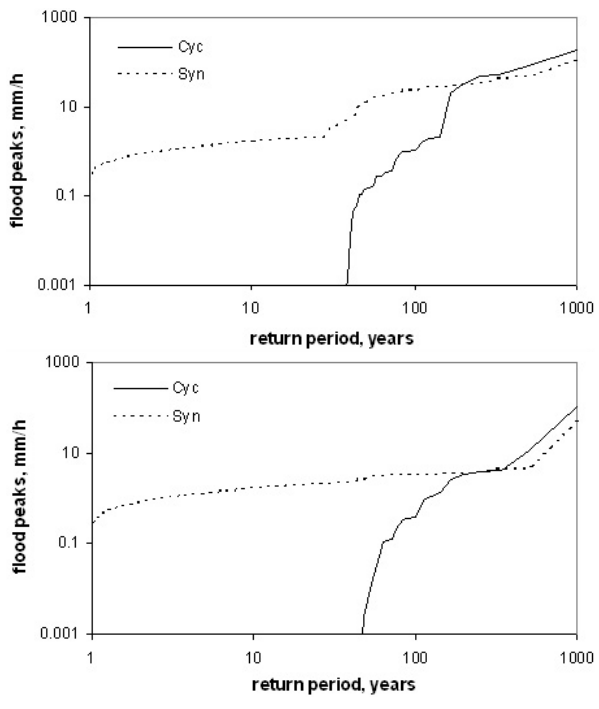
Fig. 12. Flood frequency curves generated by Model 4 using η =0.5 and (a) S b =150mm and (b) S b =300mm by synoptic storm only (Syn) compared to cyclonic summer storm only